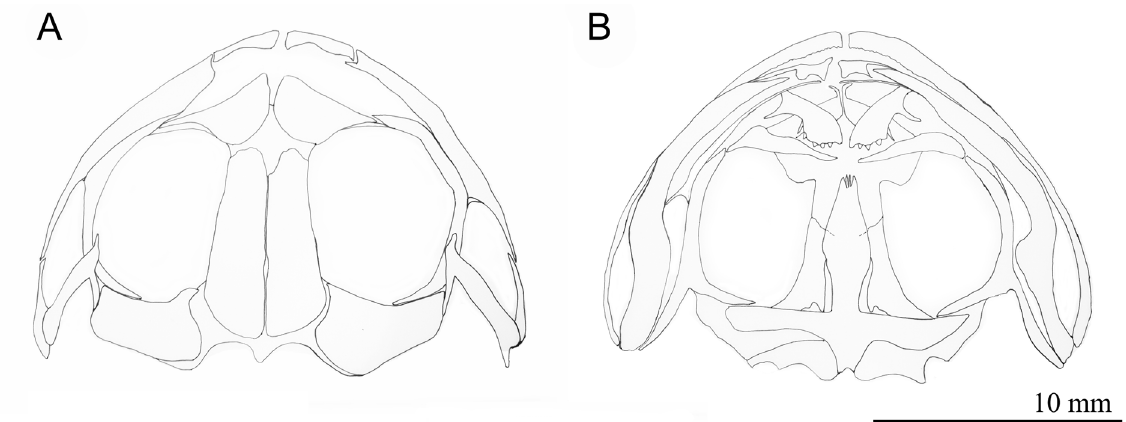
Fig. 6. Odontophrynus toledoi sp. nov. (ZUEC-AMP 23469), skull. A . Dorsal view. B . Ventral 174